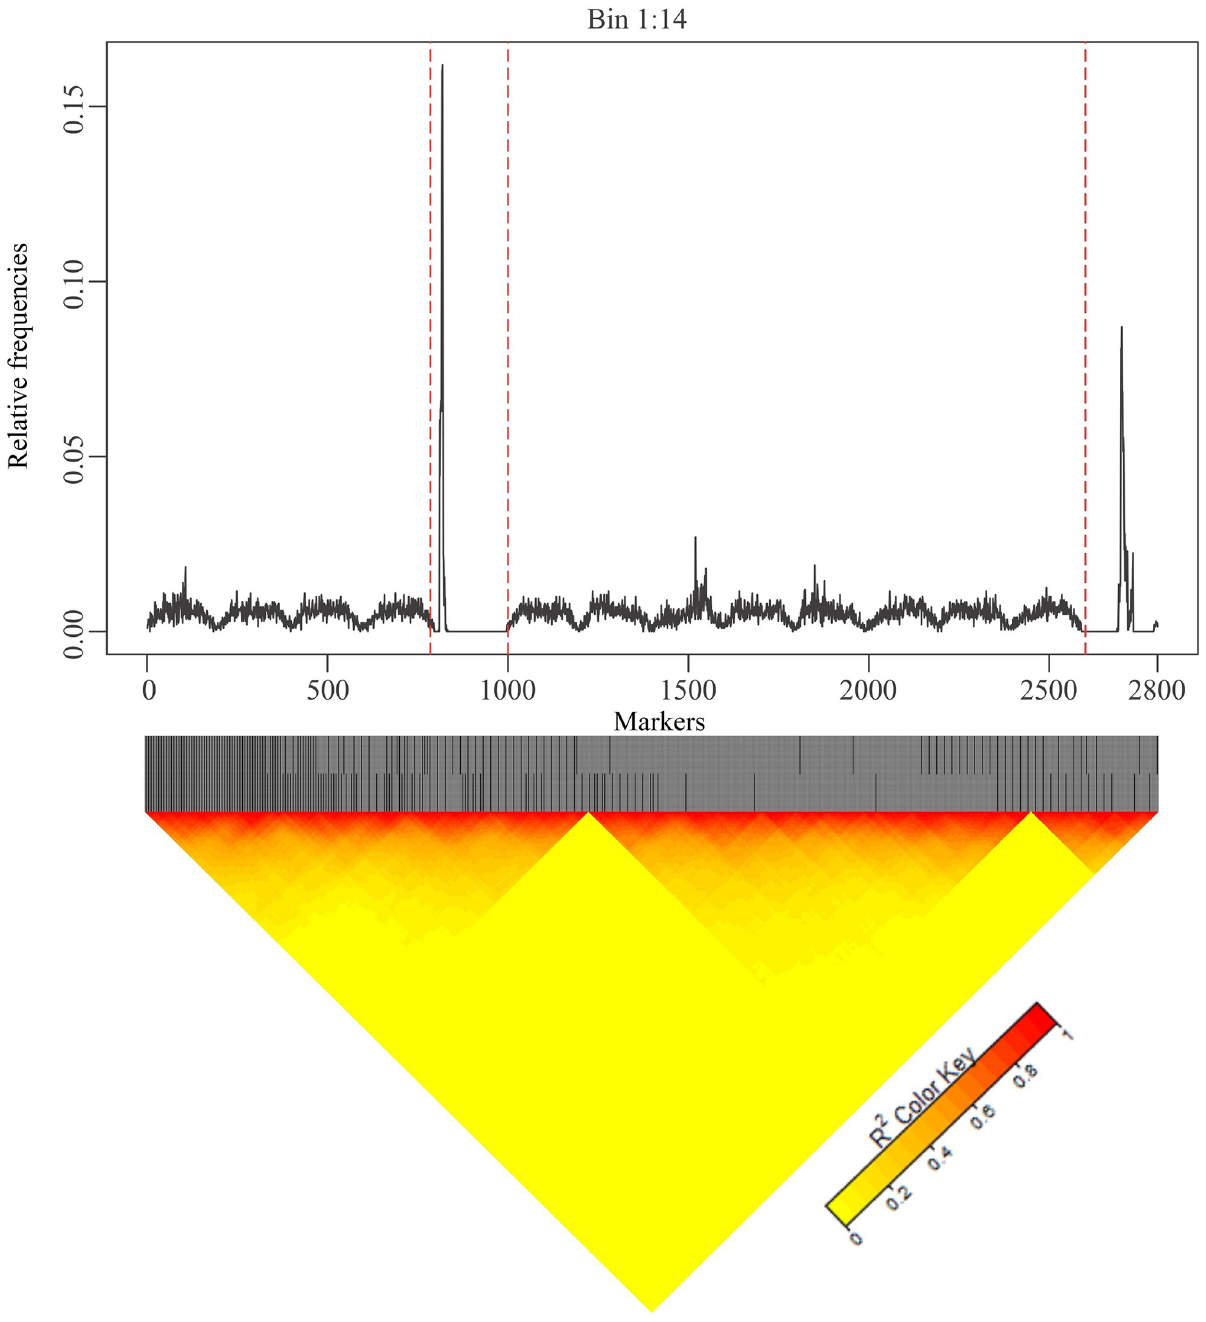
Fig 6. Genomic pattern and heat map of the first 14 bins obtained in the Bin 0.005 model. Panel A shows the genomic window related to the pattern on the first 14 bins obtained in the Bin 0.005 model. Panel B shows the heat map related to the disequilibrium pattern for correspondent genomic window. The closer to red, the greater the linkage